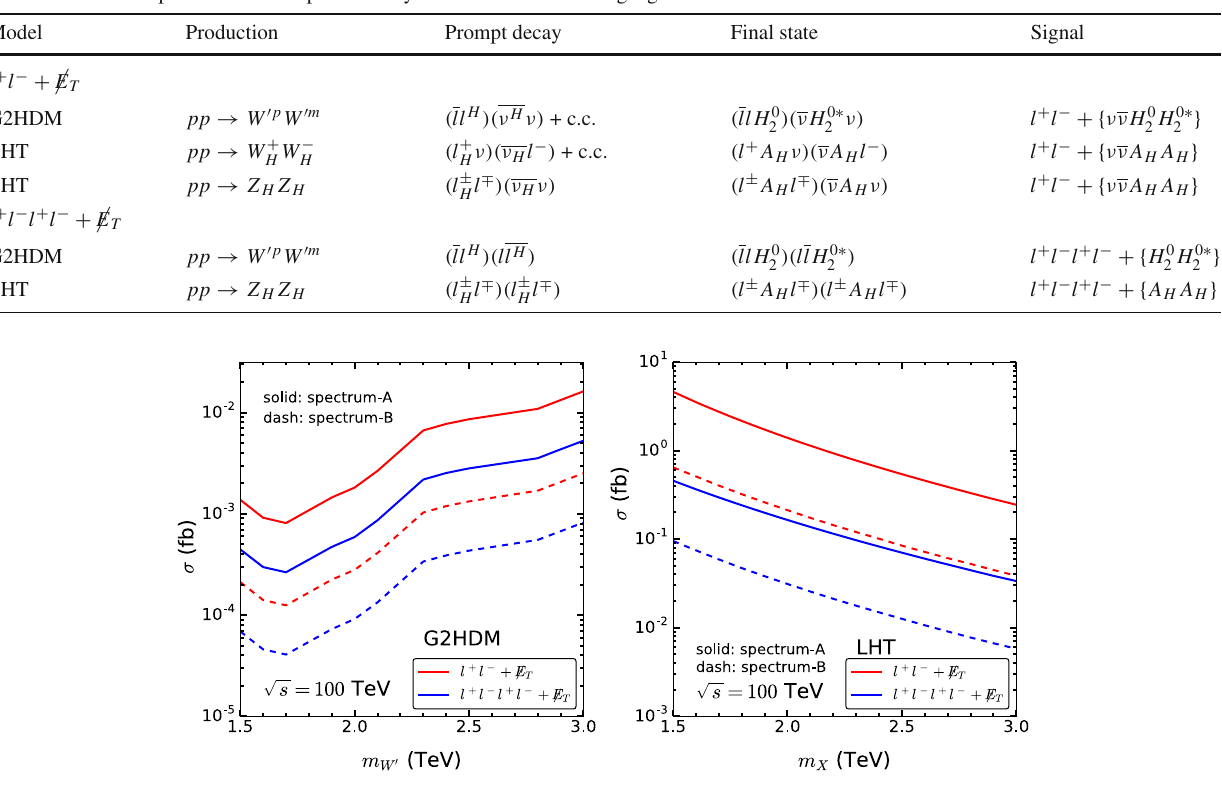
respectively. Right panel: the LHT plot similar to the left panel. The SU ( 2 ) T gaugecouplingisfixedtobetheSM SU ( 2 ) L coupling,whereas g H in G2HDM is set to be the maximally allowed value by the Z (cid:2) dilep- ton searches, presented in Fig.